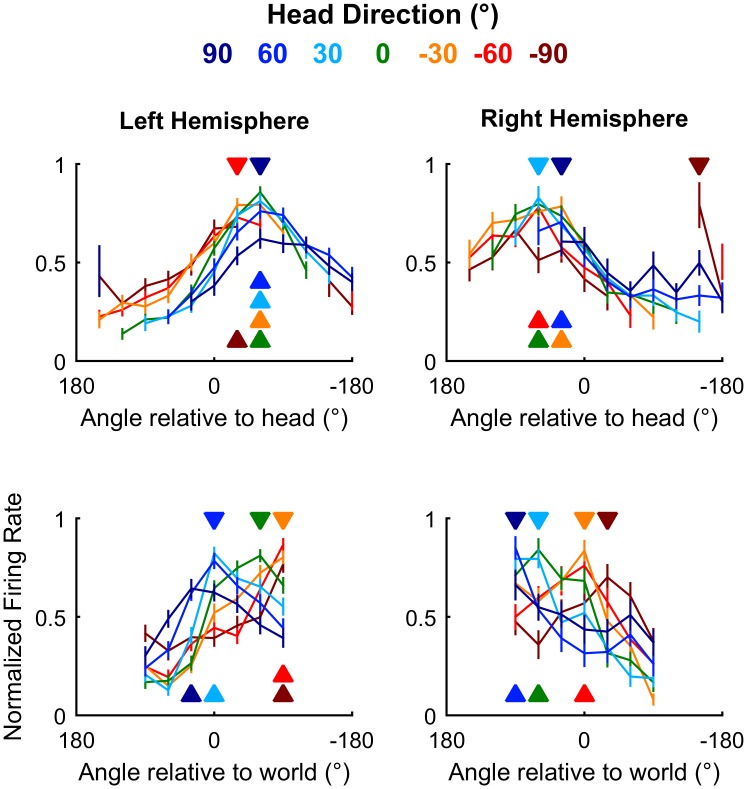
Auditory cortical tuning.Population tuning curves plotted across head direction for mean (±SEM) normalized response of all units in left and right auditory cortex; filled triangles indicate sound angle of maximum response at each head direction. Data available at https://doi.org/10.6084/m9.figshare.4955222.v1.